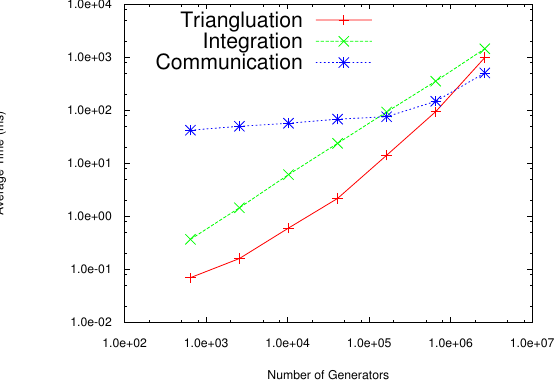
Fig. 8. Same information as in Fig. 7 but for 96 processors and 96 regions.